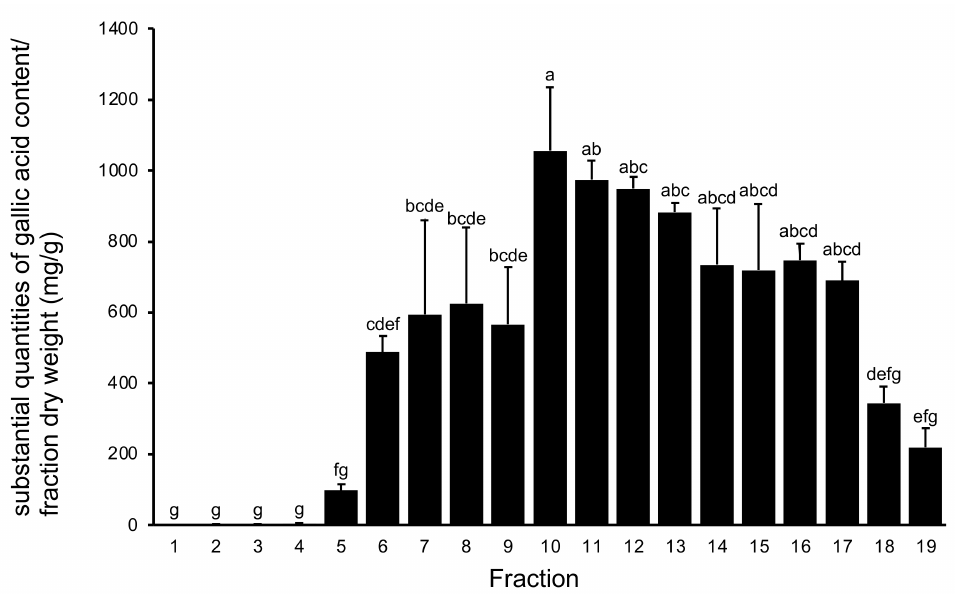
Figure 1. Total polyphenol content of fractions from water extracts of V. virgatum stems. (mg/g (dry weight of fraction)). Data are mean ± SD for three independent experiments. Different letters represent significant differences by Tukey’s multiple comparison test ( p =